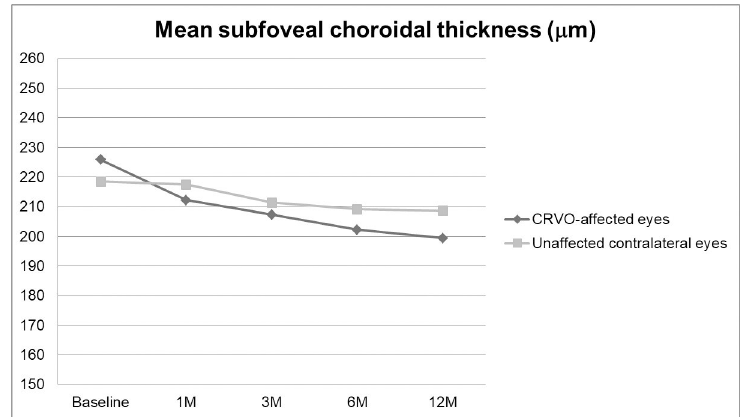
Fig 5. Changes in mean retinal nerve fiber layer (RNFL) thickness in central retinal vein occlusion (CRVO)- affected eyes and unaffected contralateral eyes. The mean RNFL thickness was significantly thicker in the CRVO- affected eyes than the contralateral eyes at baseline (P < 0.001), at 1 month (P = 0.001), and at 3 months (P = 0.013). There was no significant difference at 6 months (P = 0.068) and at 12 months (P = 0.140).